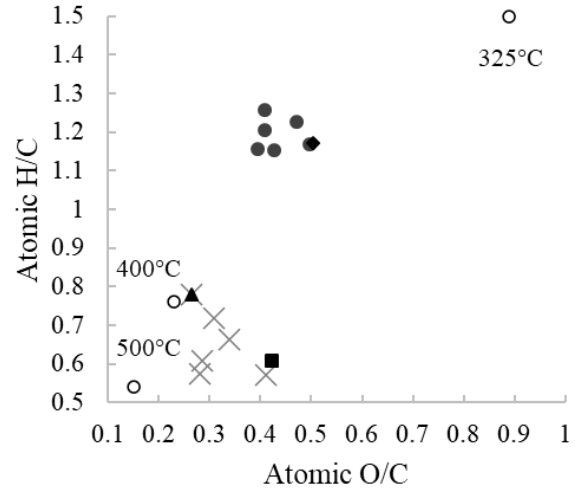
Figure 1. The van Krevelen diagram for nine of the eleven natural char samples used to fit our models. Grey circles are natural char layers, and the black symbols represent the three char endmembers used in making the admixtures. The diamond is the Michigan char, the triangle is the Minnesota char, and the square is the Canadian char. Grey crosses are macroscopic char particles found in the mineral/ organic soil interface of boreal spruce forest sites in interior Alaska (Kane et al . 2007). Open circles are cellulosic chars produced at the stated temperatures (Sekiguchi et al . 1983). Both Kane and Sekiguchi chars are included for reference purposes; see also Table A1 in the